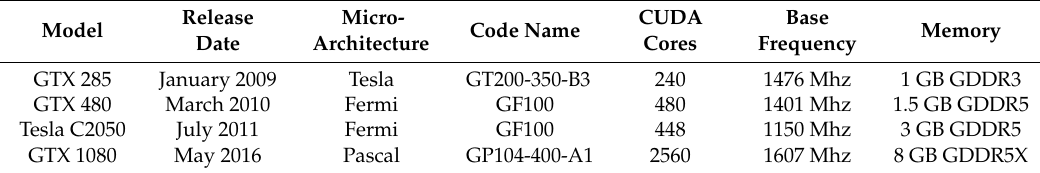
Table 1. Characteristics of the Nvidia GPUs used by the compared models. Memory units are expressed in gigabytes (GB). GDDR3, GDDR5 and GDDR5X refers to different specifications of Graphics Double Data Rate memory